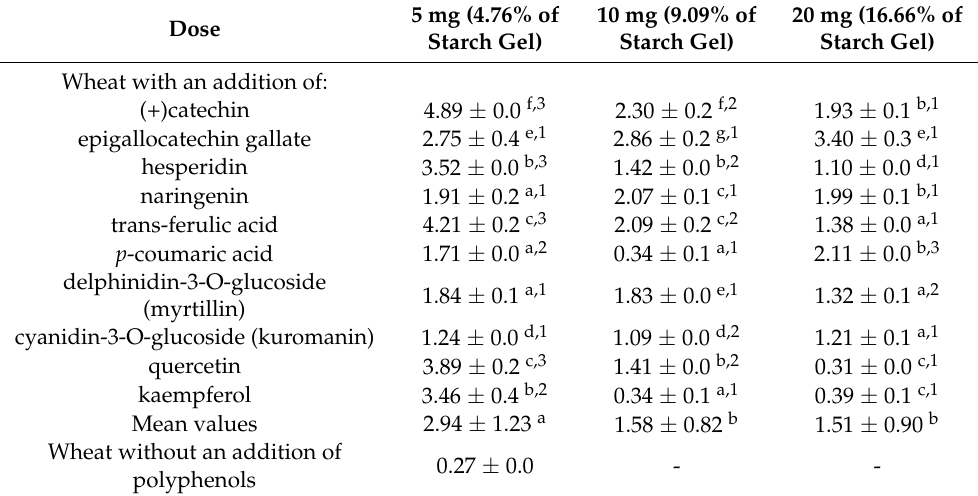
Table 1. Contents of RS in wheat starch (g · 100 g − 1 dm) depending on the type and dose of the specific polyphenol standard added.